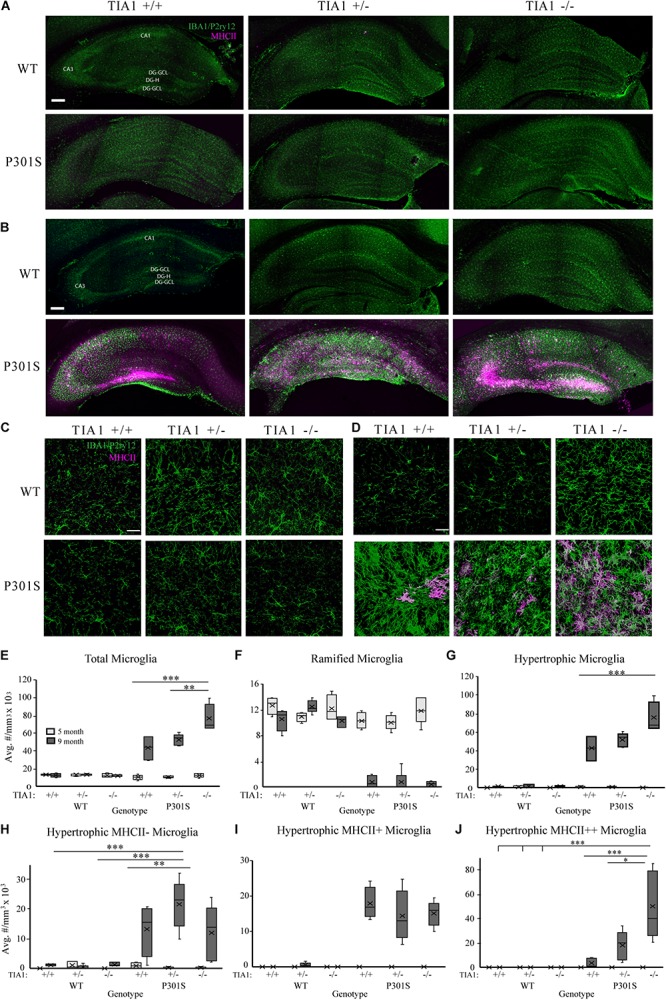
TIA1 knockout exacerbates microgliosis in advanced tauopathy. (A,B) Low resolution (10×) fluorescent confocal image stacks depicting the dorsal hippocampus in WT and P301S animals that are TIA1+/+, TIA1+/–, and TIA1–/– at 5 months (A) and 9 months (B). Microglia (IBA1 and P2ry12) are visualized in green and MHCII complex are visualized in magenta. Scale = 200 μm. Hippocampal regions labeled: Cornu Amonis 1 (CA1), Cornu Amonis 3 (CA3), Dentate Gyrus Hilus (DG-H), Dentate Gyrus Granule Cell Layer (DG-GCL). (C,D) High resolution (40×) confocal image stacks depicting the apex and adjacent dentate gyrus including the dorsal and ventral dentate granule cell layers and hilus in WT and P301S animals that are TIA1+/+, TIA1+/–, and TIA1–/– at 5 months (C) and 9 months (D). Microglia (IBA1 and P2ry12) are visualized in green and MHCII complex are visualized in magenta. Scale = 25 μm (E) Average density of total microglia in WT and P301S animals that are TIA1+/+, TIA1+/–, and TIA1–/– at 5 months (light gray) and 9 months (dark gray). (F) Average density of total ramified microglia in WT and P301S animals that are TIA1+/+, TIA1+/–, and TIA1–/– at 5 months (light gray) and 9 months (dark gray). (G) Average density of total hypertrophic microglia in WT and P301S animals that are TIA1+/+, TIA1+/–, and TIA1–/– at 5 months (light gray) and 9 months (dark gray). (H) Average total density of MHCII- hypertrophic microglia in WT and P301S animals that are TIA1+/+, TIA1+/–, and TIA1–/– at 5 months (light gray) and 9 months (dark gray). (I) Average density of MHCII + hypertrophic microglia in WT and P301S animals that are TIA1+/+, TIA1+/–, and TIA1–/– at 5 months (light gray) and 9 months (dark gray). (J) Average density of MHCII ++ hypertrophic microglia in WT and P301S animals that are TIA1+/+, TIA1+/–, and TIA1–/– at 5 months (light gray) and 9 months (dark gray). n = 4–7 subjects/genotype for all measures. All statistical comparisons calculated with One-Way ANOVA with Bonferroni post hoc test, ∗p ≤ 0.05, ∗∗p ≤ 0.01, ∗∗∗p ≤ 0.001.